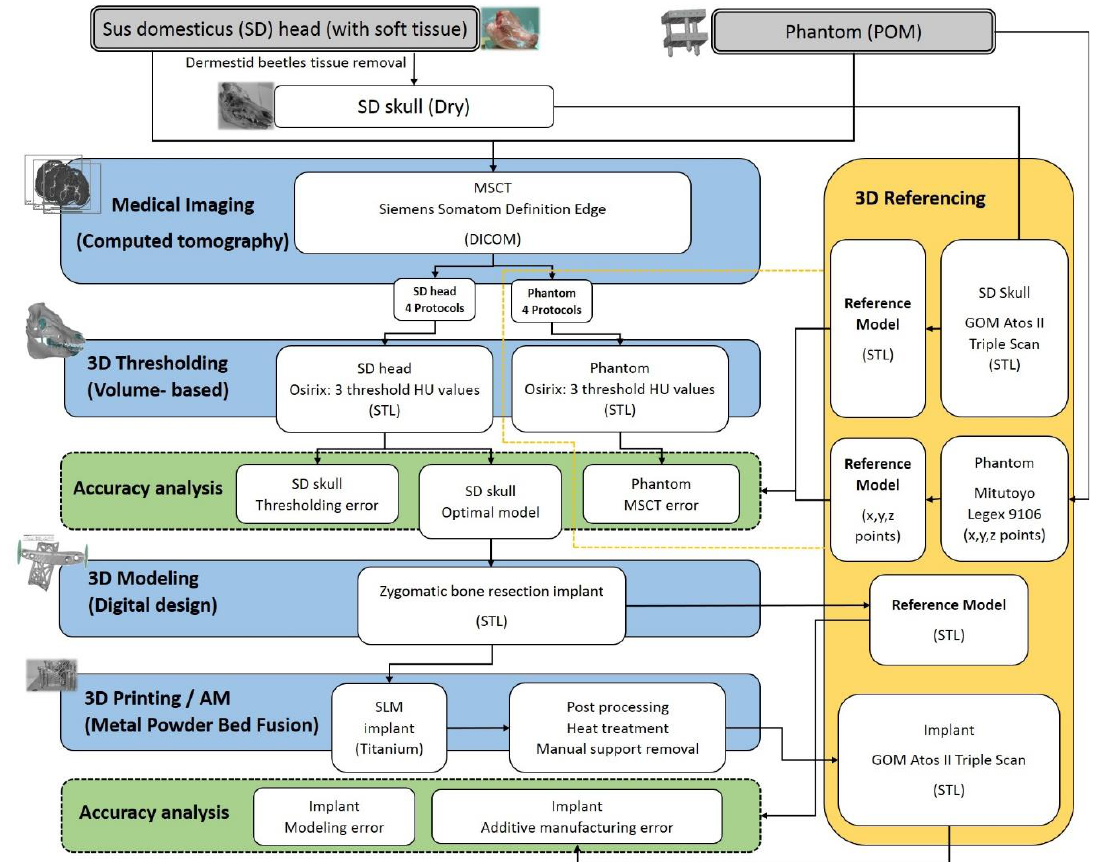
Figure 1. The process of evaluating cumulative inaccuracies for an end-use implant.